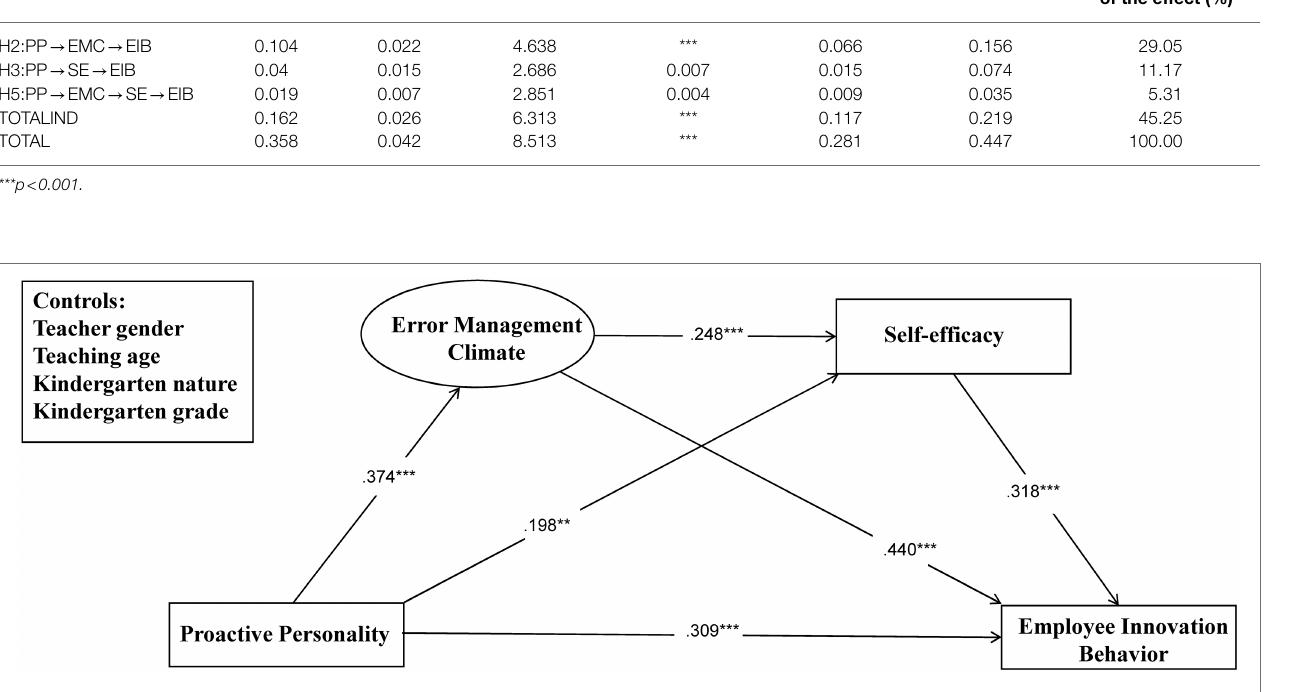
TABLE 4 | The indirect effect of the research paths. Path Std. Est.